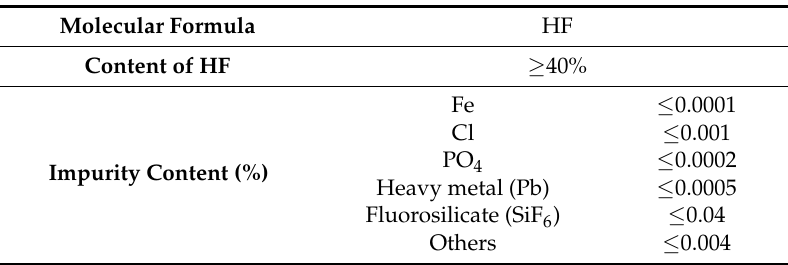
Table 2. The chemical composition of hydrofluoric acid.